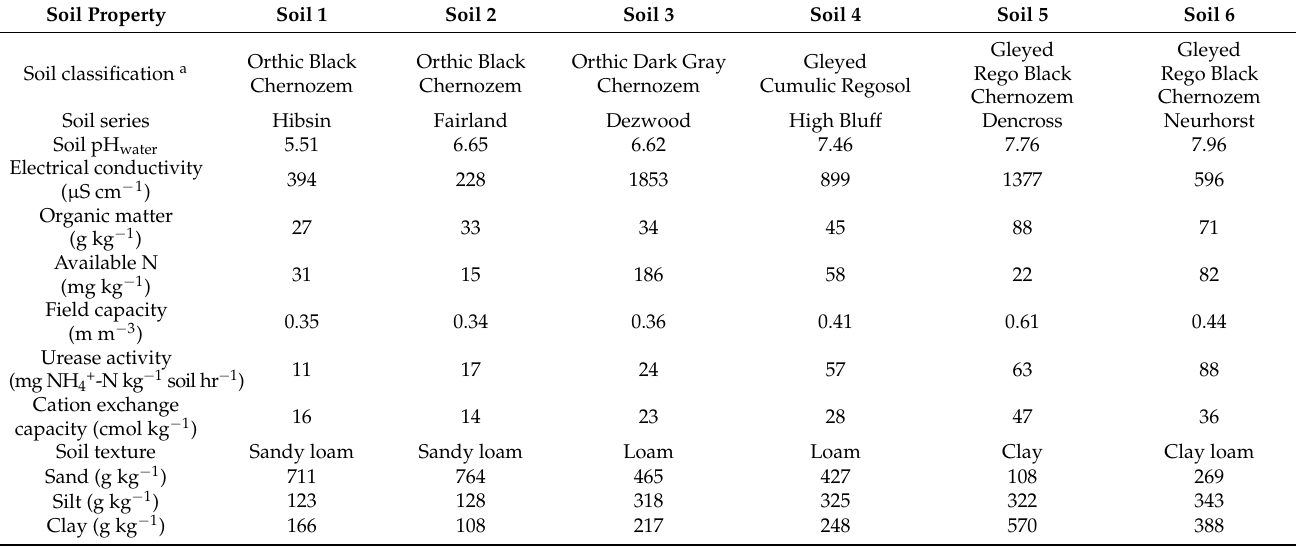
Table 1. Selected soil (0–15 cm)